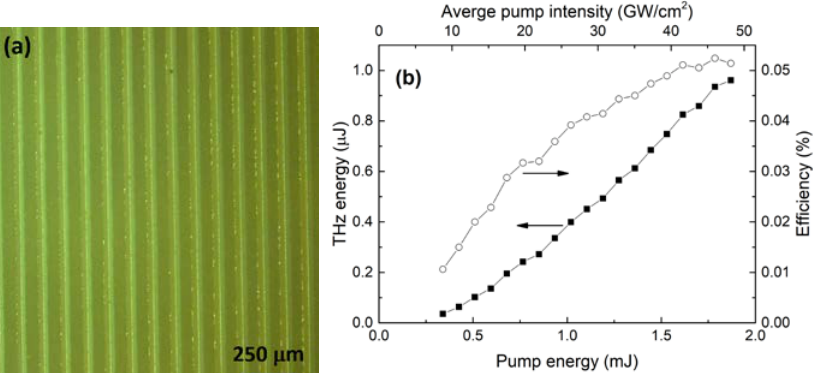
Fig. 2. (a) Microscope image of the prototype NLES surface showing the stair- step structure. (b) Measured THz pulse energy (left axis) and THz generation efficiency (right axis) as functions of the pump energy and